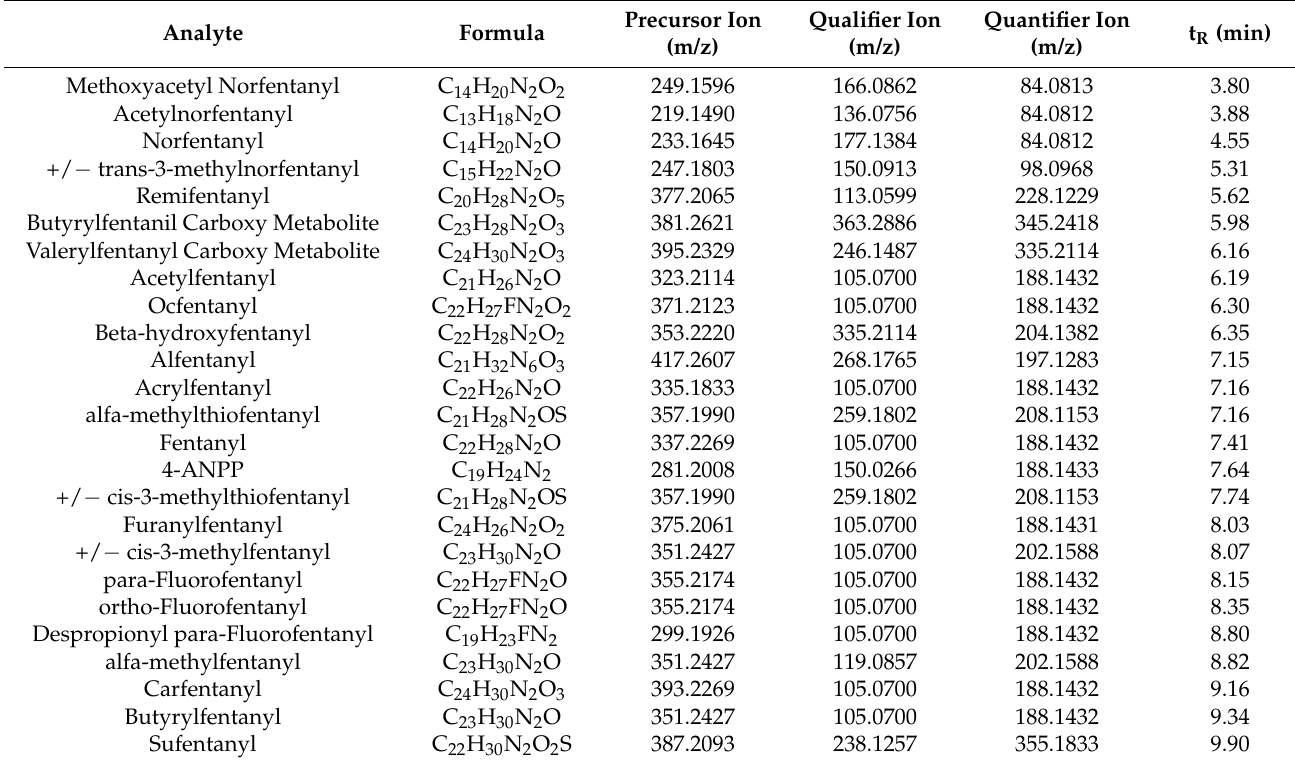
Table 4. LC–MS/HRMS parameters; formula, precursor ion, qualifier ion, quantifier ion and retention time for all the target